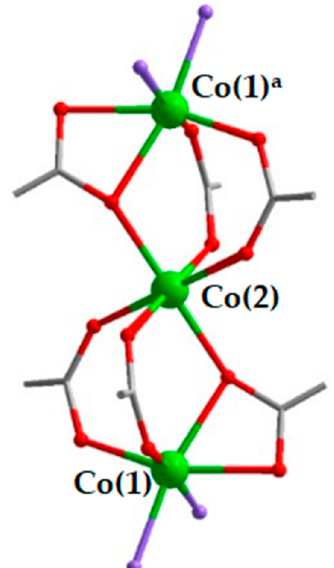
Figure 1. Structure of the {Co 3 (RCOO) 6 } building unit in 1 – 3 . Co–green; O–red; C–grey. Purple atoms indicate either O atoms of the dmf solvent molecules and/or N atoms of the auxiliary ligands (2,2 ′ -bpy, pz). a generated by inversion center.